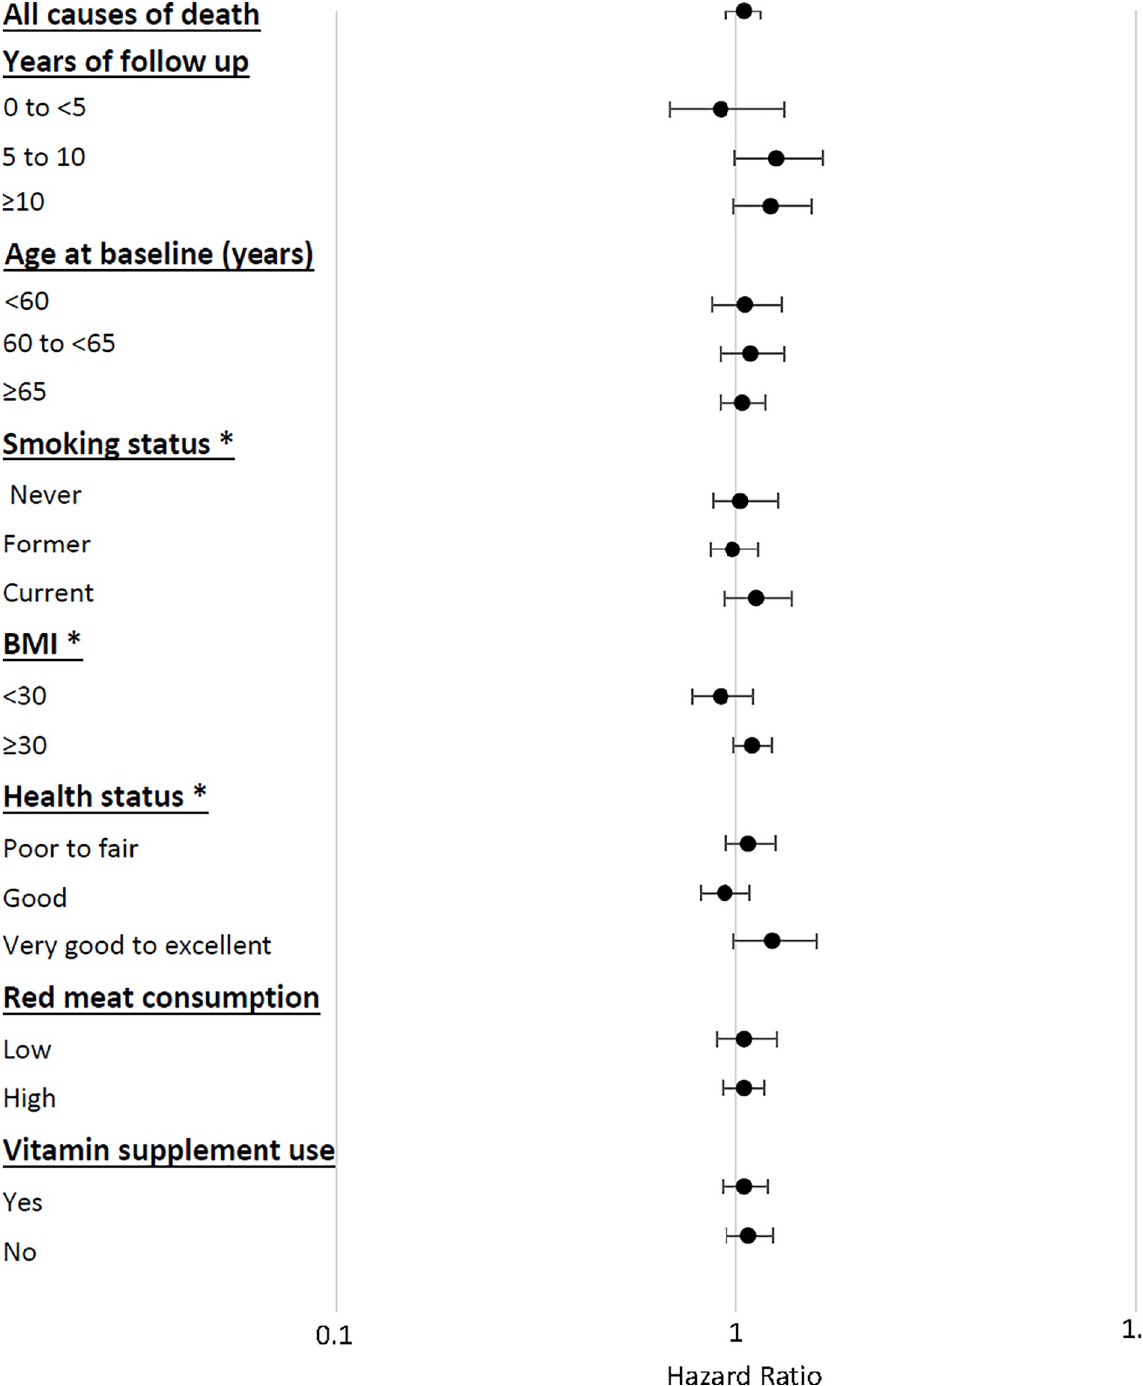
Fig 2. Hazard ratios for overall mortality, for total potato consumption stratified by categories of suspected risk factors. Point estimates represent highest vs. lowest category of potato consumption adjusted for age (years), sex (M, F),use or non-use of pipes or cigars, the number of cigarettes smoked per day, time of smoking cessation ( < 1 year, 1 to < 5 years, 5 to < 10 years, or � 10 years before baseline), alcohol drinking (grams per day), ethnicity (non-Hispanic White, non-Hispanic Black, Hispanic, Asian/Pacific Islander/Native American), body mass index (BMI) (kg/m 2 ), education (high school or less, post-high school training, college graduate, post-graduate education), physical activity (never, rarely, 1–3 times per month, 1–2 times per week, 3–4 times per week, � 5 times per week), self-report history of diabetes (yes, no), total energy intake (kcal per day, quintile), red meat intake, white meat intake, whole grain intake, fruit intake, and vegetable intake (grams per day, quintile); HRs (95% CIs) were calculated by using a Cox regression model. � P for interaction < 0.05.